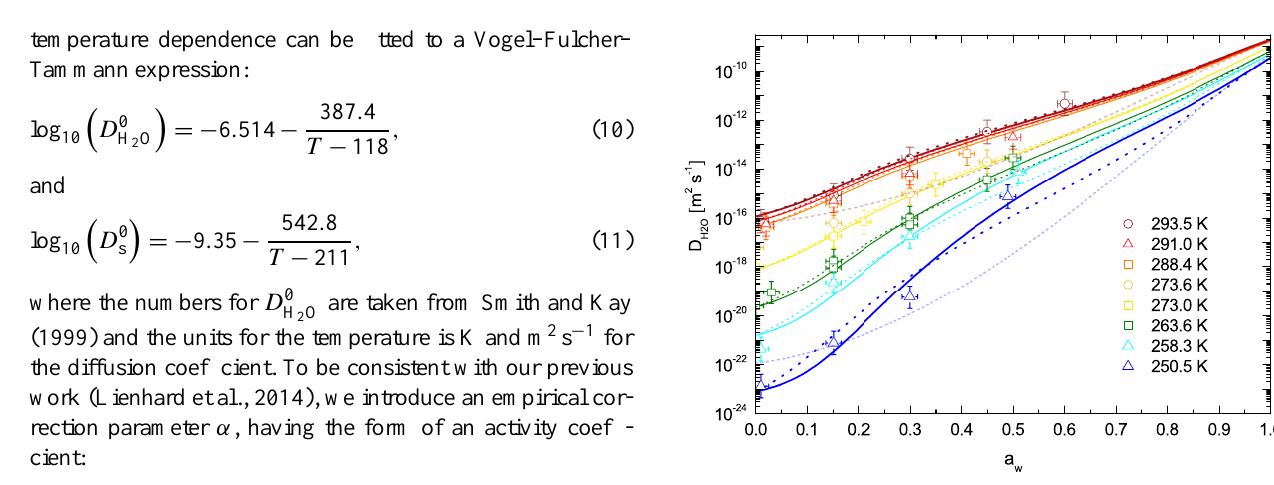
Figure 9. D H as a function of a w for the investigated tempera- 2 O tures indicated by different colors. Different symbols represent dif- ferent particles. The lines represent fits to Eq. (9). Solid lines were fitted with an α calculated according to Eq. (12), dotted lines with α = 1. For comparison, the faint, short, dashed lines in correspond- ing colors show the parametrization of D H for sucrose of Zobrist 2 O et al. (2011) for 250.5 and